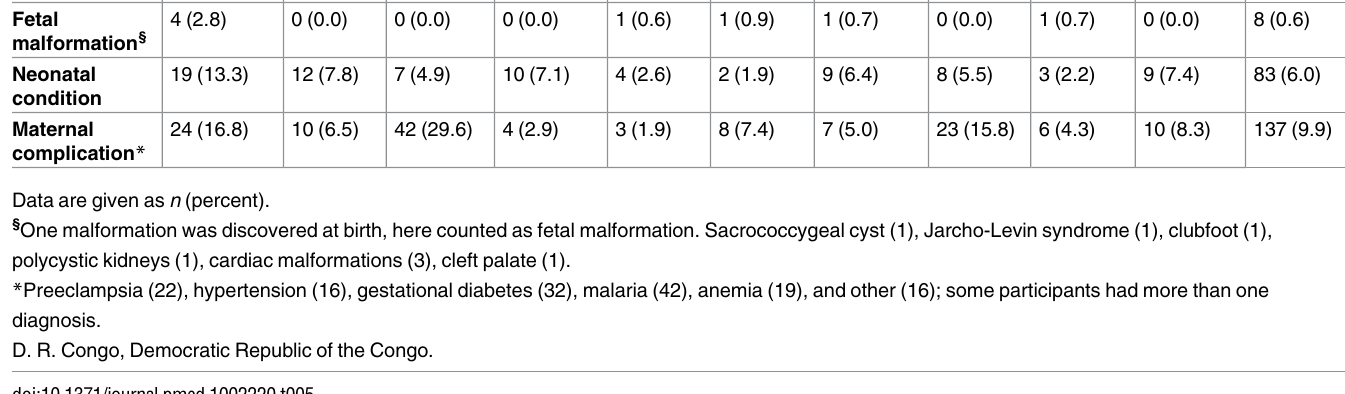
Maternal Complications and Perinatal Conditions Conditions occurring in the mother during pregnancy are shown in Table 5, together with fetal malformations and neonatal conditions. In addition to globally experienced maternal complications such as preeclampsia, pregnancy-induced hypertension, gestational diabetes, and anemia, 42 had identified malaria. There was no maternal death. Four small-for-gesta- tional-age fetuses were identified clinically, of which two were examined using Doppler ultra- sound; none had abnormal recordings in the umbilical artery or middle cerebral artery, and all were kept in the analysis. It was registered when neonates needed transmission to the neonatal intensive care unit, commonly due to prematurity, respiratory distress syndrome, infections, Table 5. Maternal complications, fetal malformations, and neonatal conditions by country. Condition Argentina Brazil D. R. Denmark Egypt France Germany India Norway Thailand All ( N = 143) ( N = 153) Congo ( N = 140) ( N = 155) ( N = 108) ( N = 141) ( N = 146) ( N = 138) ( N = 121) ( N = 1,387) ( N = 142) Fetal 4 (2.8) 0 (0.0) malformation § Neonatal condition Maternal 24 complication *